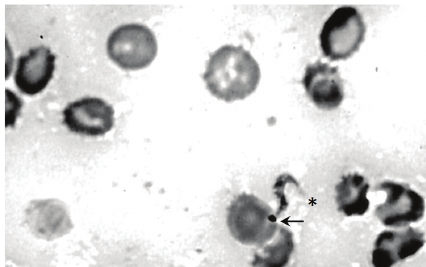
Figure 1: Cytology of leptomeninges imprints. Note the presence of an S -shaped trypomastigote compatible with the morphology of a Trypanosoma sp. ( → ) kinetoplast, ( ∗ ) free flagellum (Giemsa stain, × 400).